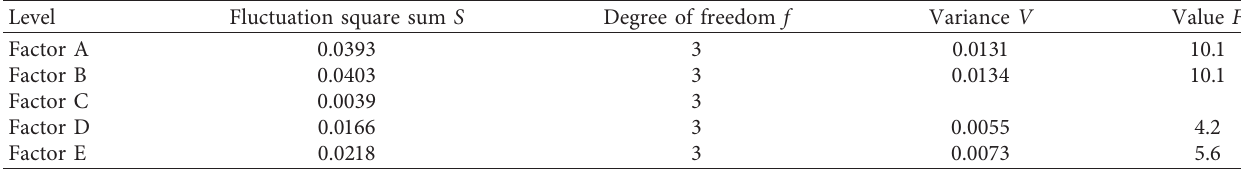
Table 13: Variance data analysis.